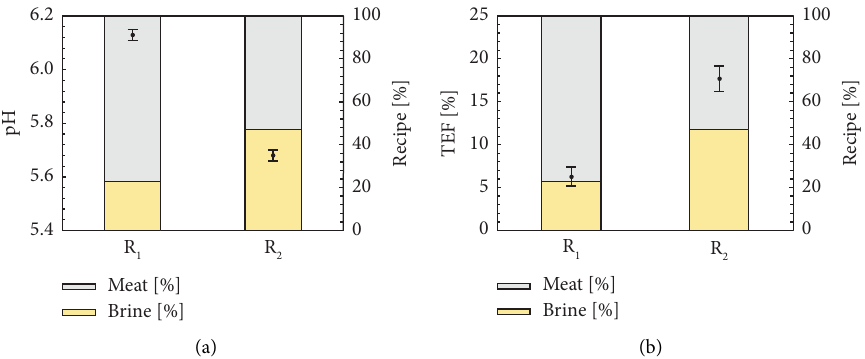
1 and R 2 . Content of meat (grey) and brine